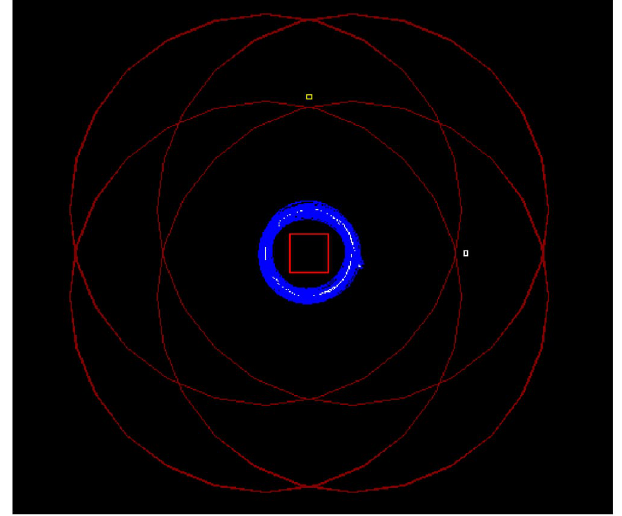
FIG. 3. (Color) The same conditions as Fig. 2, but viewed looking down the cooling channel. The beam here is at 200 MeV =c with a helix radius of 11 cm. The outlines of the radially displaced rf cavities are shown in red. The red box shown for orientation in the center is 10 cm on a side.